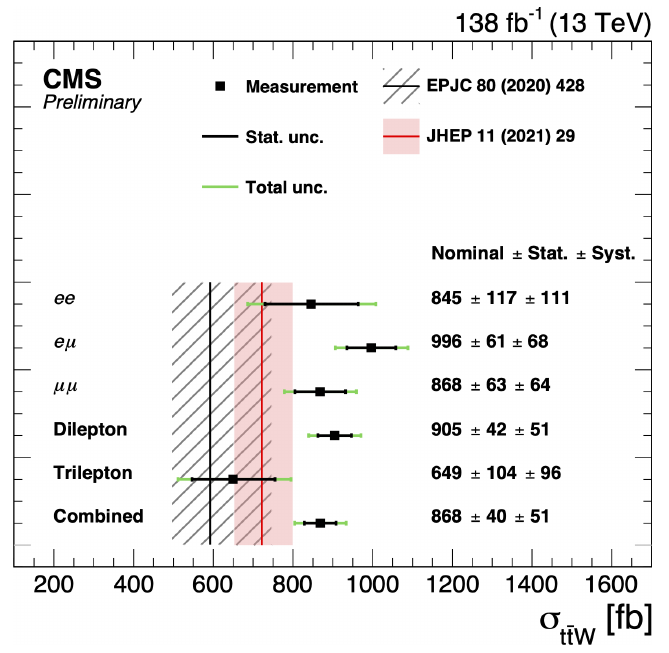
Figure 12. Measurements of the inclusive t¯tW cross − section [41]. The combined result is shown with a breakdown of the measurement obtained in the different dilepton and tri − lepton channels, as well as the measurement obtained in the different lepton flavour categories of the dilepton channel. The black inner error bar indicates the statistical uncertainty, while the green outer error bar represents the full systematic plus statistical uncertainty. The measurements are compared with two SM predictions. The prediction shown by the black line is from Ref. [31] while the prediction represented by the red line comes from Ref. [29] and includes FxFx predictions. The central lines of these two vertical lines represent the nominal prediction, while the band represents the combined uncertainty from the scale and PDF theory variations in the